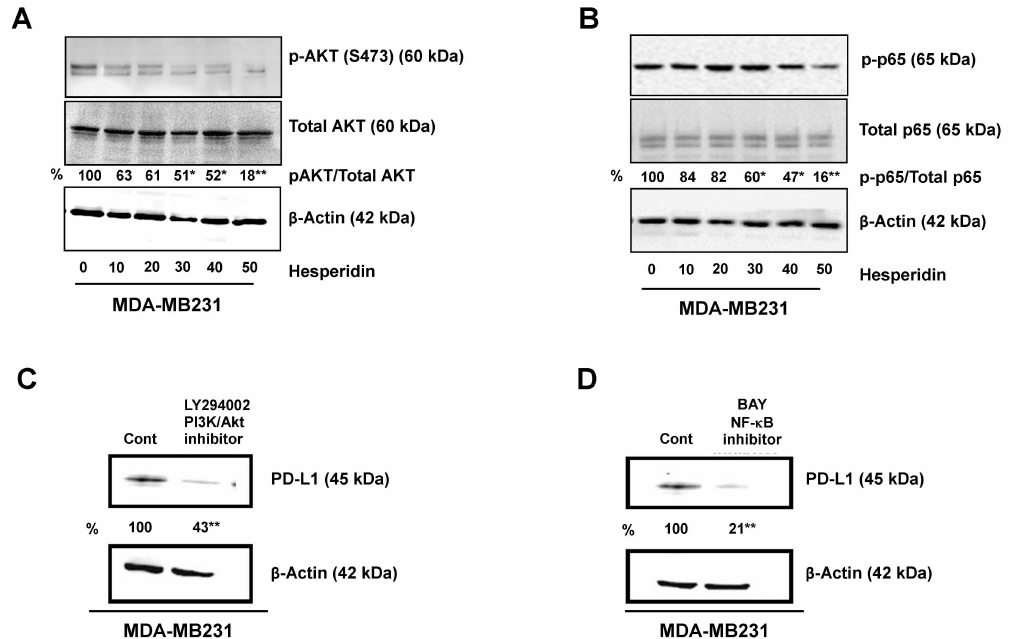
Figure 4. Downregulation of PD-L1 protein via inhibition of Akt and p65 phosphorylation in MDA-MB231 cells treated with hesperidin: ( A ) Phosphorylation of Akt, ( B ) phosphorylation of p65, and ( C,D ) PD-L1 protein in the absence or presence of inhibitor (PI3K / Akt LY294002 inhibitor and NF- κ B inhibitor BAY) Statistical significance * p < 0.05 and ** p <